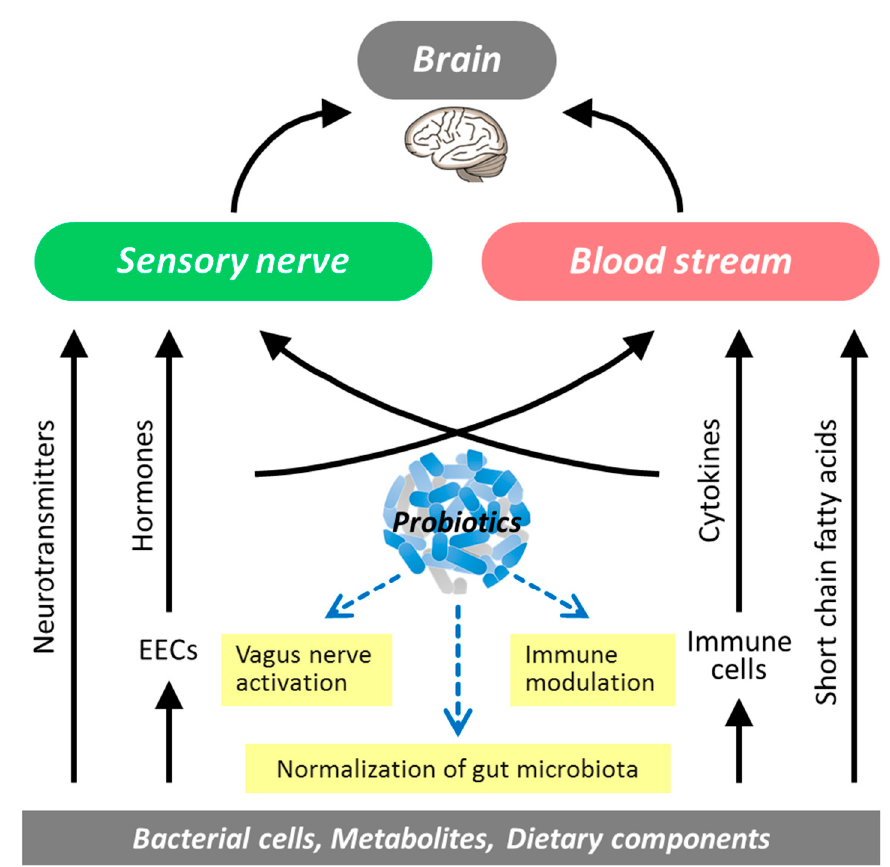
Figure2. Modulationofthemicrobiota–gut–braininteractionbyprobiotics. EECs, Figure 2. Modulation of the microbiota–gut–brain interaction by probiotics. EECs, enteroendocrine cells.